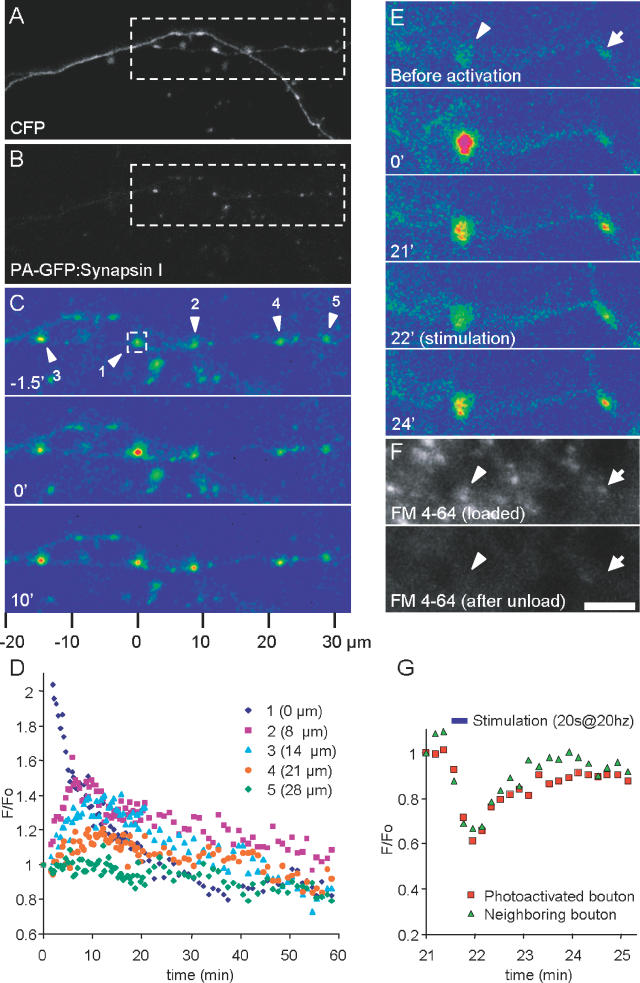
Synapsin I Lost from One Bouton Is Incorporated into Adjacent BoutonsAn axonal segment expressing both CFP (A) and PA-GFP:Synapsin I (B).(C) Higher magnification of region enclosed in rectangle in (B). PA-GFP:Synapsin I within a single bouton was photoactivated by selective illumination of this bouton at 405 nm (t = 0). Within 10 min of photoactivation, fluorescence at this bouton had decreased, whereas fluorescence at adjacent boutons (distances of 8 to 21 μm) had increased significantly. PA-GFP:Synapsin I fluorescence encoded in pseudo-color as in Figure 1.(D) Quantification of fluorescence changes following photoactivation at photoactivated and adjacent boutons. Note the rapid reduction of fluorescence at the photoactivated site and the concomitant (but transient) increases recorded at adjacent boutons that were most prominent at boutons nearest to the photoactivation site.(E) Synapsin lost from one bouton is incorporated into the presynaptic matrix of adjacent boutons. Two presynaptic boutons along an axonal segment expressing PA-GFP:Synapsin I. At time t = 0, PA-GFP:Synapsin I within one bouton (arrowhead) was photoactivated by selective illumination at 405 nm, and the redistribution of the photoactivated material was followed by time-lapse microscopy. At 21 min after photoactivation, a brief (20s@20Hz) stimulation train was delivered, leading to the transient dispersion of PA-GFP:Synapsin I at the photoactivated bouton as well as at the second bouton that had incorporated some of photoactivated PA-GFP:Synapsin I (arrow). PA-GFP:Synapsin I fluorescence encoded in pseudocolor as in Figure 1.(F) FM4–64 labeling at the end of the experiment confirmed that both sites were functional presynaptic boutons. Bar, 5 μm.(G) Normalized fluorescence of both boutons before, during, and after the stimulation episode. Note that PA-GFP:Synapsin I in the neighboring bouton exhibited activity induced dispersion just like Synapsin in the photoactivated bouton, indicating that the PA-GFP:Synapsin that had migrated to it had become incorporated into its presynaptic matrix.